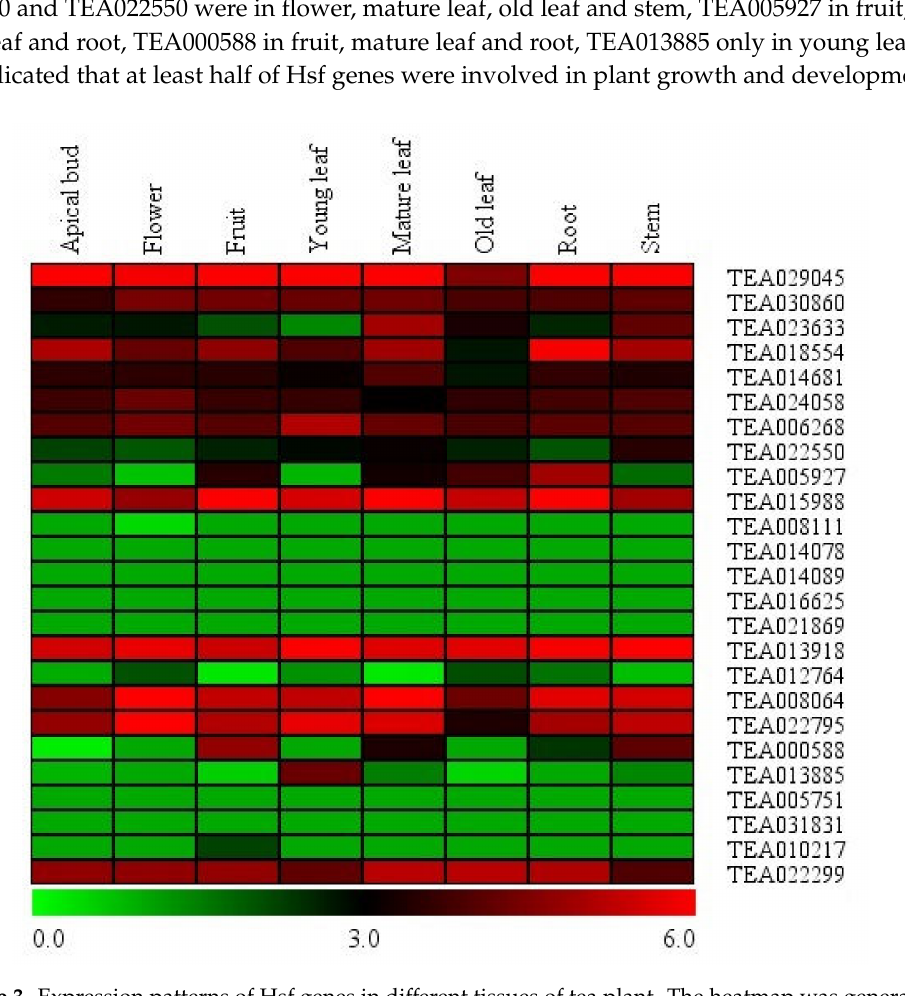
Figure 3. Expression patterns of Hsf genes in di ff erent tissues of tea plant. The heatmap was generated by MeV software (TIGR, Rockville, MD, USA) using the Hsf genes’ expression data, and normalized log 2 transformed values were used with hierarchical clustering. The red and green colors indicate higher or lower transcript abundances than those of the relevant control,